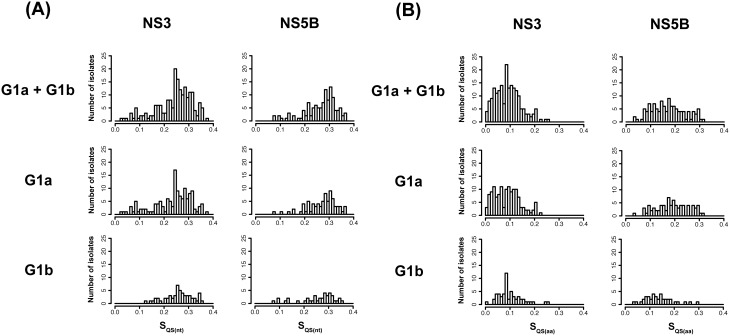
Histograms of baseline quasispecies diversity in the study population, as represented by Shannon entropy in nucleotides (A) and in amino acids (B).Sequence variants were assembled using ShoRAH (as described in material and methods) and only variants with frequencies ≥0.5% were included.